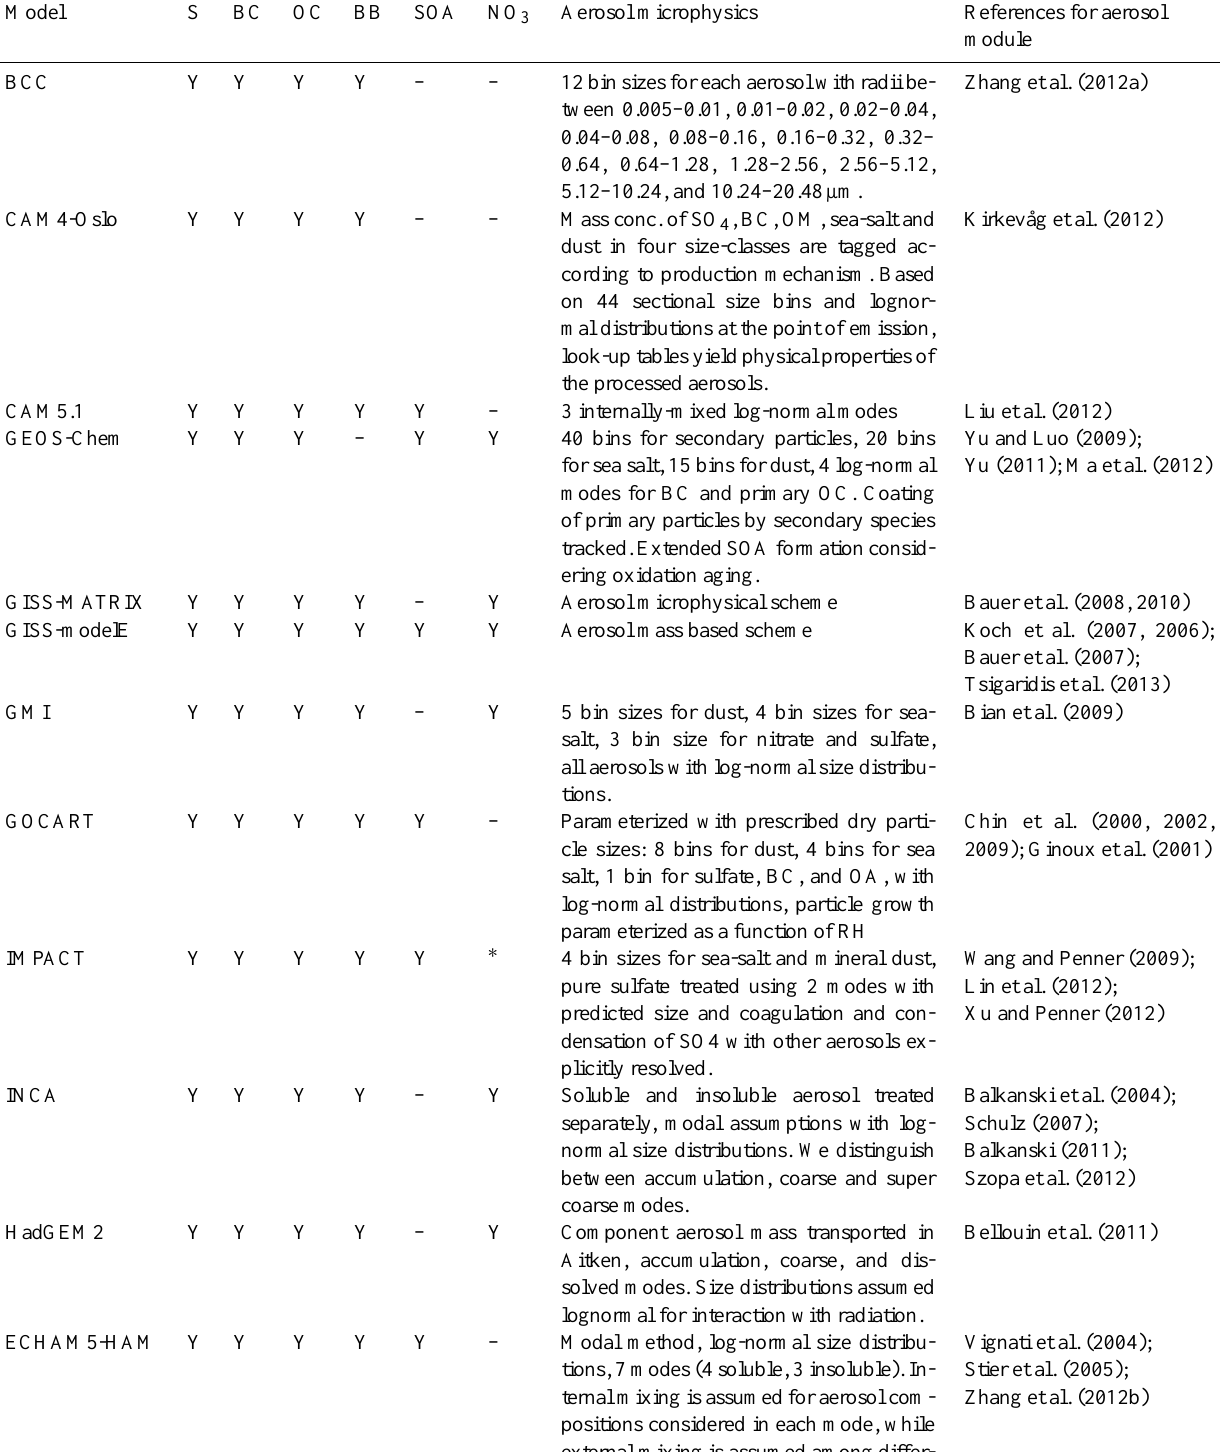
Table 2. Model description, aerosol information.